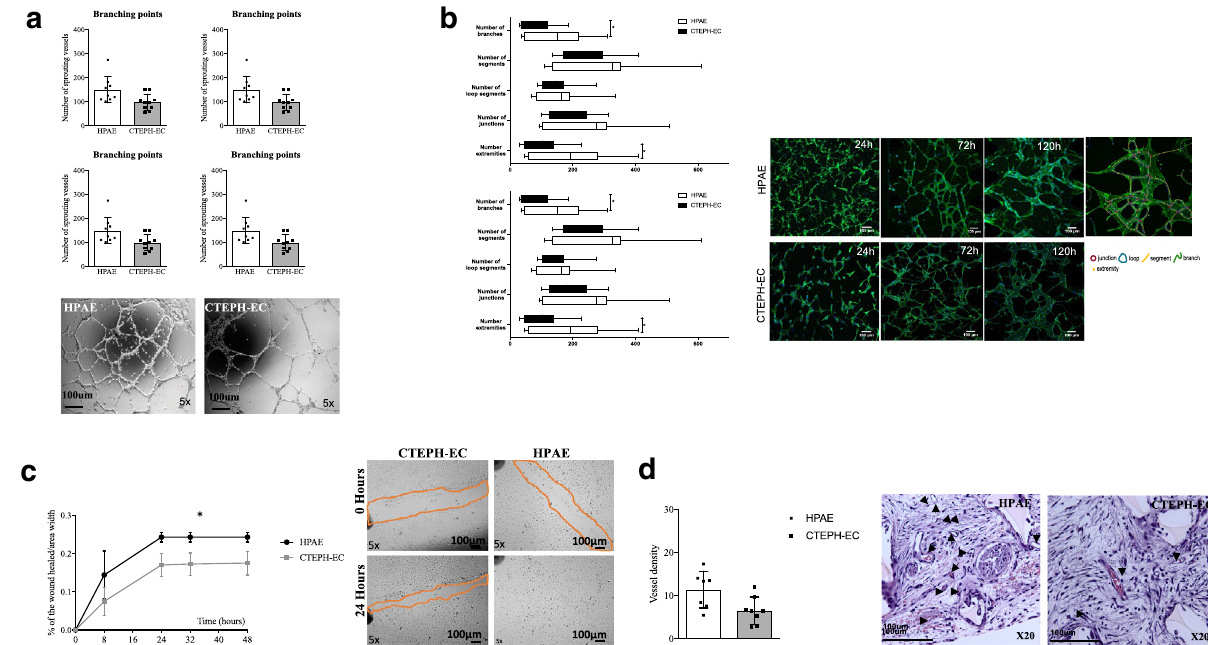
Figure 6. Functional characterization of CTEPH-EC. ( a ) In vitro angiogenic potential of CTEPH-EC quantified by the number of branching points, tube length, cell covered area and number of loops. Representative pictures of spontaneous tube formation in HPAE and CTEPH-EC, n = 9 HPAE, n = 10 CTEPH-EC independent experiments performed in triplicate, p < 0.05*, p < 0.01**, Mann–Whitney U test, values expressed as mean ± SD. ( b ) Quantification of cell connections and geometrical features measured at 24, 72 and 120 h and representative pictures of HPAE and CTEPH-EC. p < 0.05*, p < 0.05*, Mann–Whitney U test values expressed as mean ± SD. ( c ) Migration capacity of CTEPH-EC and HPAE in the wound healing assay. Percentage of wound closure is measured at 8, 24, 32 and 48 h and plotted as the percentage of closure over the average area of width. Representative pictures of wound closure at 0 h and 24 h in HPAE and CTEPH-EC, n = 6 HPAE, n = 7 CTEPH-EC, p < 0.01**, Mann–Whitney U test at 8 h, 24 h, 32 h and 48 h, values expressed as mean ± SD. ( d ) In vivo angiogenic potential of CTEPH-EC- and HPAE-embedded sponge pellets quantified by the number of vessels in the sponge sections. Representative pictures of vessels in sponges embedded with HPAE and CTEPH-EC. n = 7 HPAE, n = 8 CTEPH-EC independent experiments, p < 0.05*, Mann–Whitney U test, values expressed as mean ± SD. Statistical analysis was performed with GraphPad Prism 7 software, version 7.0e, serial number:GP7-0633739-R###-#####, https:// www. graph pad.